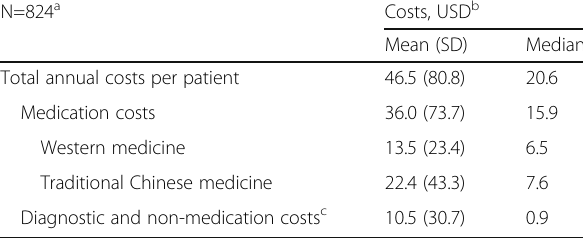
Table 4 Annual outpatient costs per patient N=824 a Costs, USD